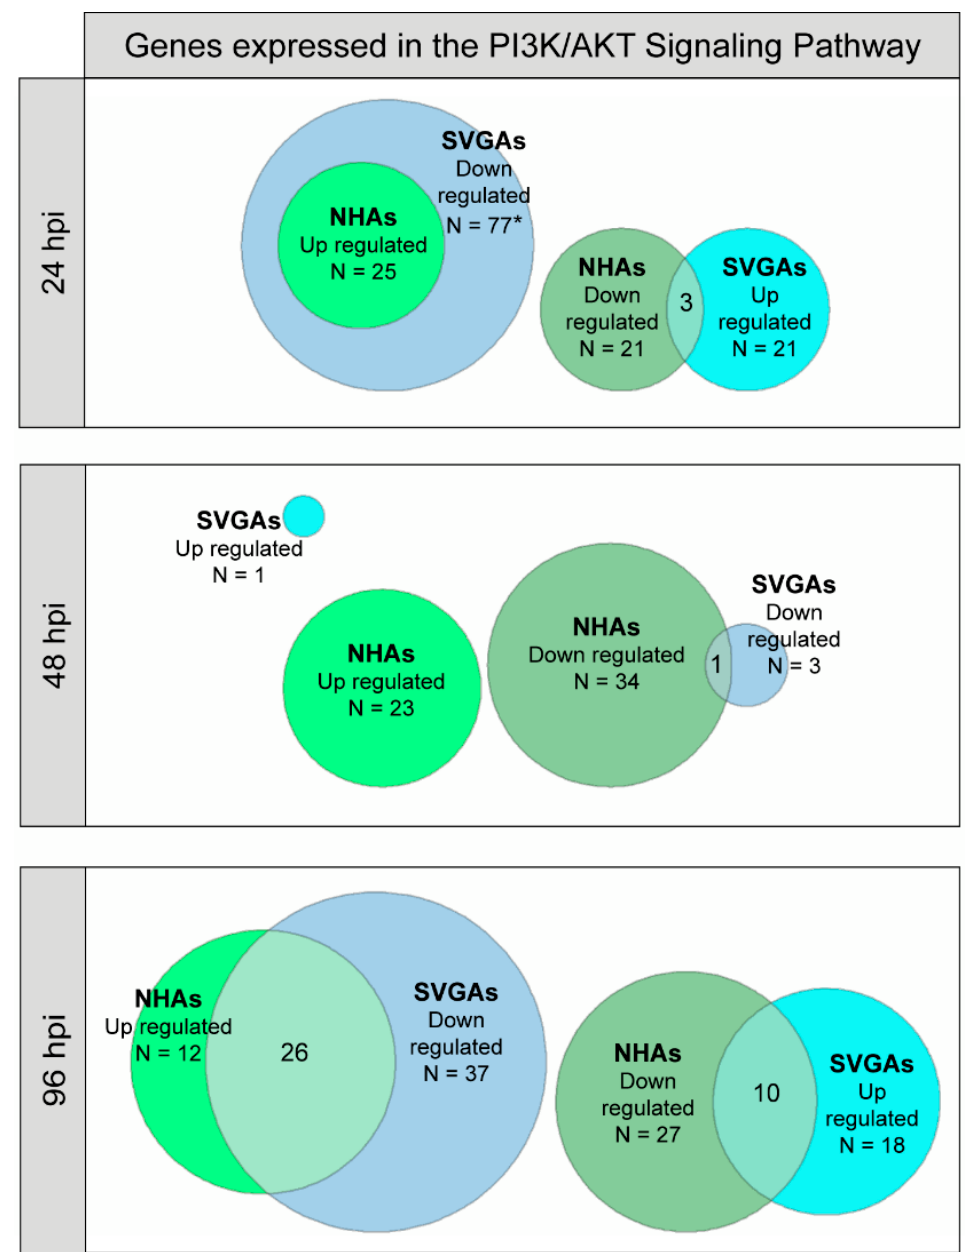
Figure 3. Genes in the PI3K/AKT pathway were differentially expressed during JCPyV infection in NHAs compared to viral infection in SVGAs. NHAs and SVGAs were either infected with JCPyV (MOI = 0.1 FFU/cell) or mock-infected with a vehicle control, and the transcriptomic profile was determined at 24, 48, and 96 h using RNA-seq. Genes of the PI3K/AKT pathway were determined from the KEGG database with an unadjusted p value < 0.10. Upregulated genes (Log FC > 0) and downregulated genes (Log FC < 0) are represented as Venn diagrams for each time point and cell type. The size of each circle is proportionate to the number of genes that apply to the above criteria. The green colors are representative of NHAs, while the blue colors are representative of SVGAs. Brighter shades represent upregulated genes and darker shades represent downregulated genes. (FC, fold-change; * 77 genes in total are down regulated in SVGAs, but 52 genes are exclusively downregulated in SVGAs.).